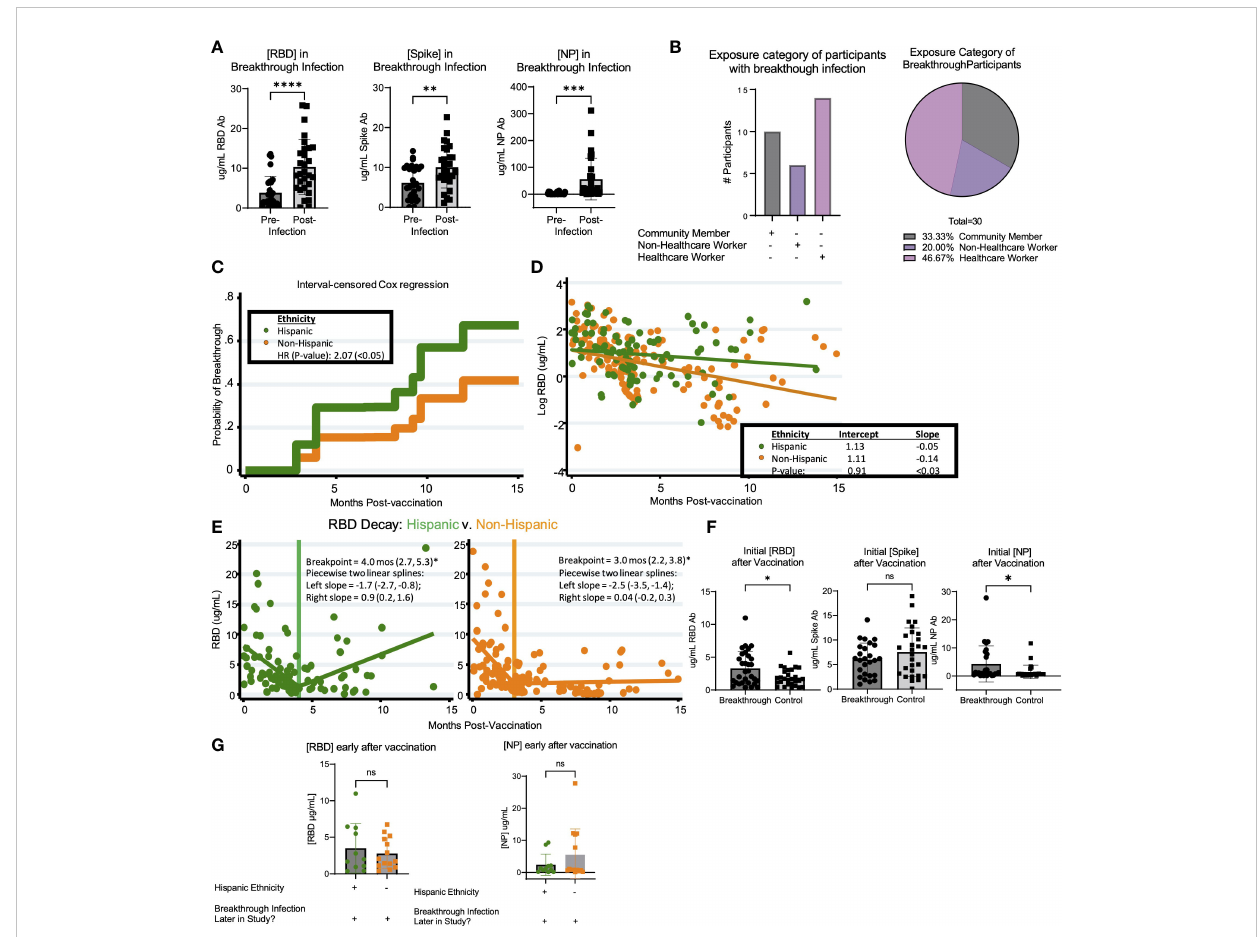
FIGURE 4 Breakthrough infection in vaccinated LA-SPARTA participants is more prevalent in Hispanic participants. (A) shows the change in RBD, Spike, and NP concentration between the reported and serologically detected breakthrough infections at the prior blood sample before the breakthrough infection was either reported or detected and after. (B) shows the distribution of risk category in the participants with breakthrough infections by number (left) and percentage (right). (C) An interval-censored regression model was used to compare the hazard ratios for breakthrough infection between Hispanic and Non-Hispanic participants. The Kaplan Meier curve is shown to represent this analysis. (D) shows the decay rate for antibodies against both RBD and Spike proteins on the log scale between Hispanic and non-Hispanic vaccinated participants. Panel (E) shows the piecewise linear regression model to fi nd times at which the slopes of raw values change among Hispanic (left plot) and non-Hispanic participants (right plot). This analysis included 65 Hispanic participants, who contributed 95 samples and 93 non-Hispanic participants, who contributed 148 samples to the analysis. (F) shows the concentration of RBD, Spike, and NP after roughly 1-4 months after vaccination, in participants who had breakthrough infection later in the study and control participants who did not have breakthrough infection. (G) shows the concentration of RBD and NP after roughly 1-4 months after vaccination, in participants who had breakthrough infection later in the study according to ethnicity.* designates P >0.05, ** designates P >0.01, *** designates P >0.001, and **** designates P >0.0001. ns, not signi fi